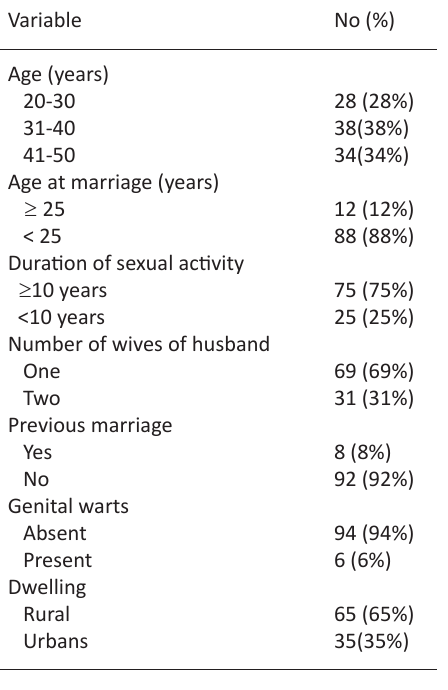
Table 1. Total number of women and demographic